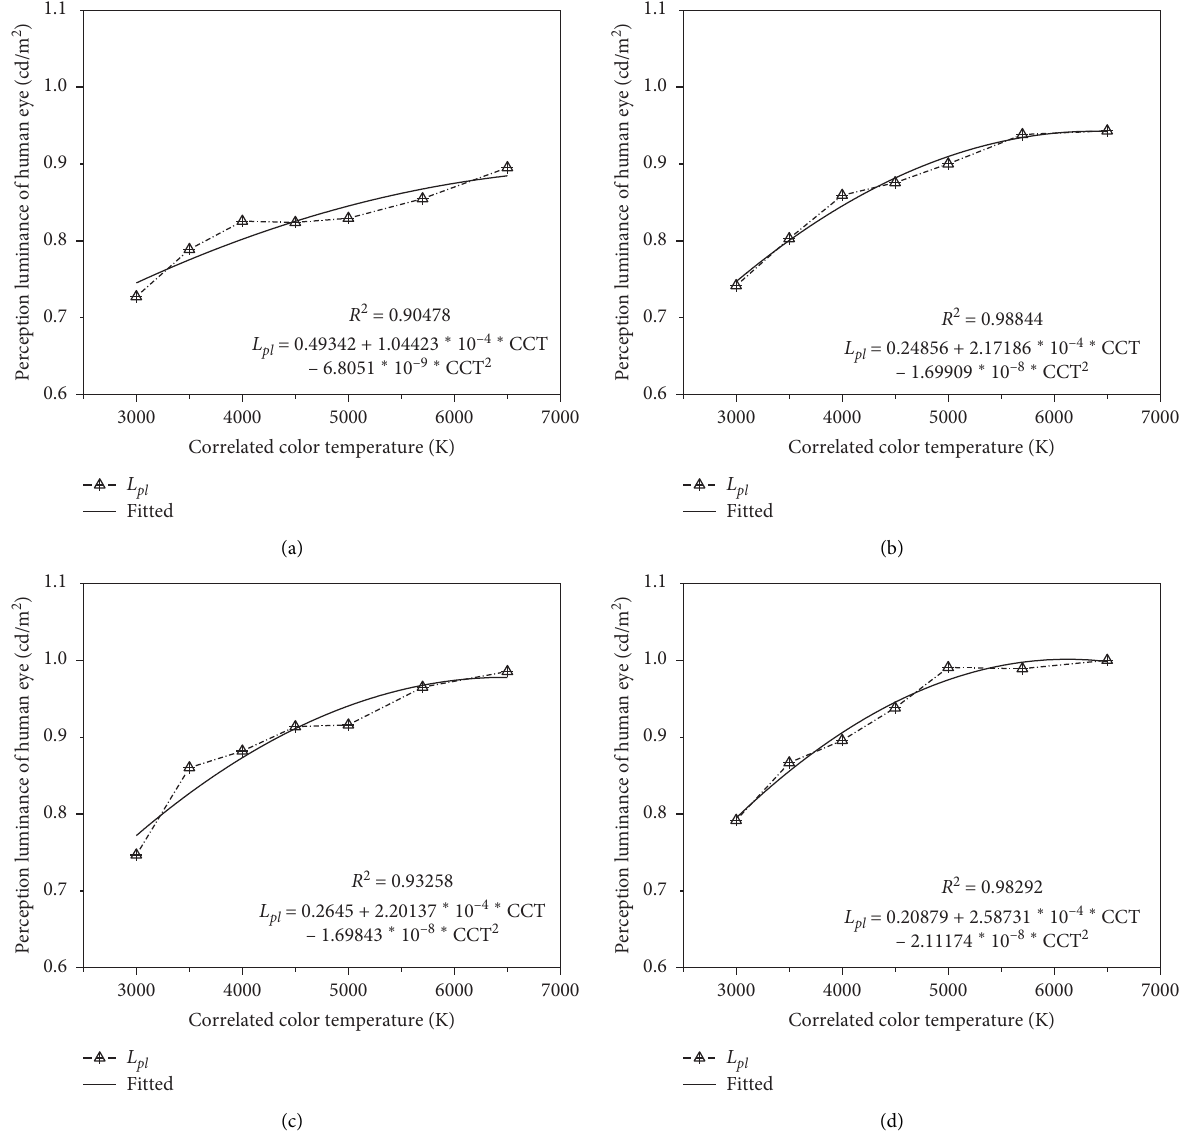
Figure 6: Perception luminance of the human eye. (a) CRI2012 � 65. (b) CRI2012 � 75. (c) CRI2012 � 85. (d) CRI2012 �